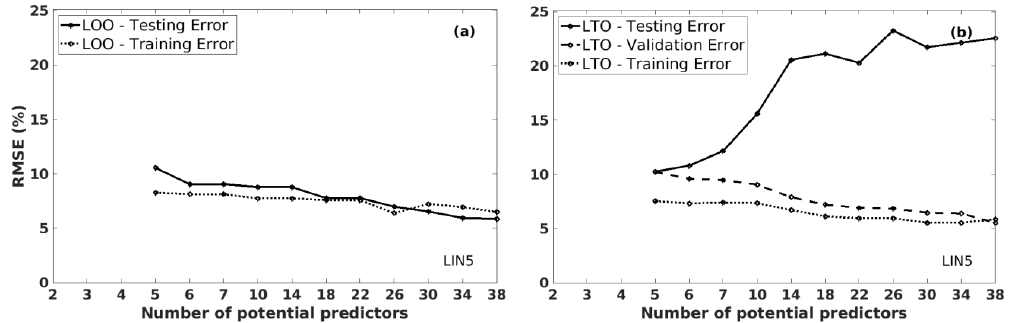
Figure 6. The training, validation, and/or testing RMSE values of the predicted coffee yield anomalies, using LIN5 models by increasing the number of potential predictors, in Cu M’gar (Dak Lak, Vietnam): (a) is induced from the LOO procedure, and (b) is from the LTO